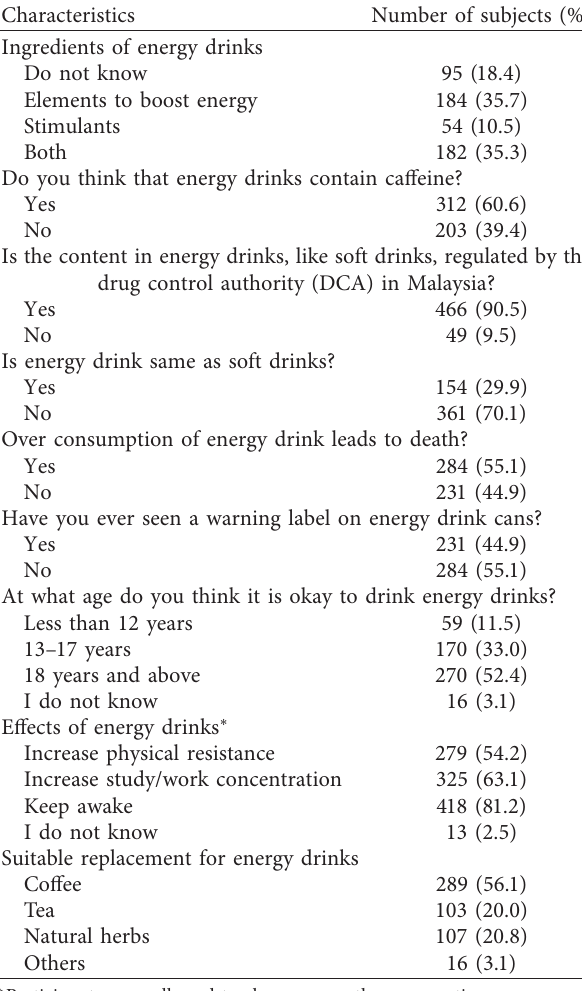
Table 2: The knowledge and perception of participants towards energy drinks.